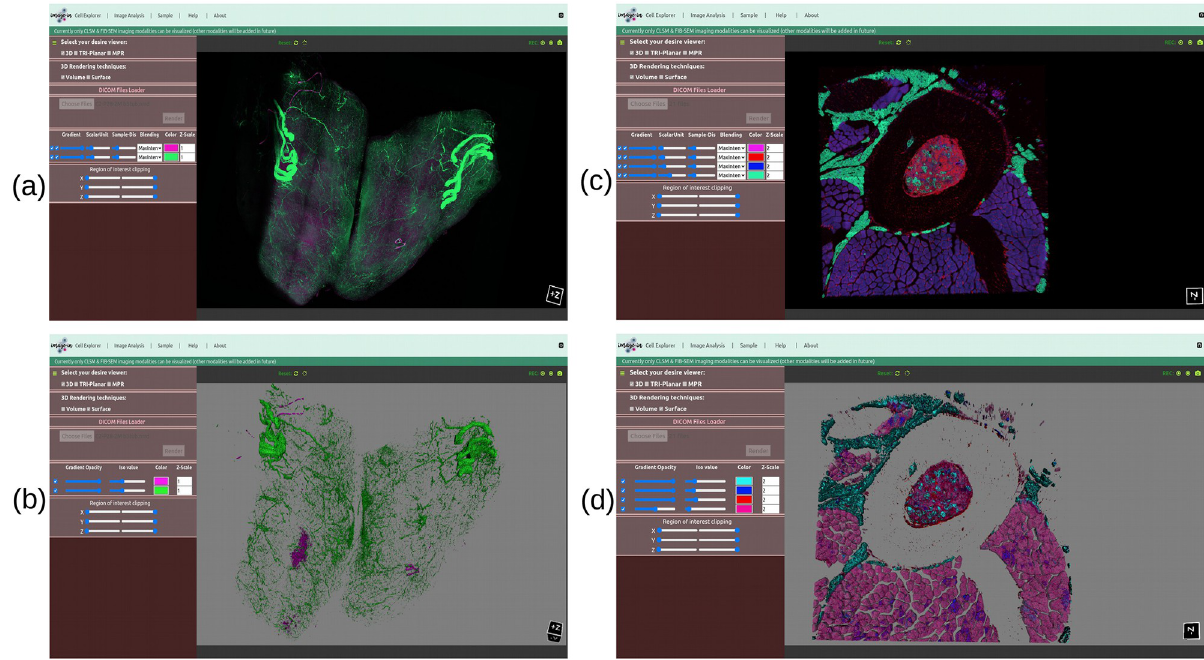
Fig 11. The two-channel adipose tissue [43] and four-channel tibia bone tissue [C3H-SEC9] [27] CLSM dataset is rendered in both (a, c) volume and (b, d) surface rendering views. In each view, each channel is rendered in a different color.